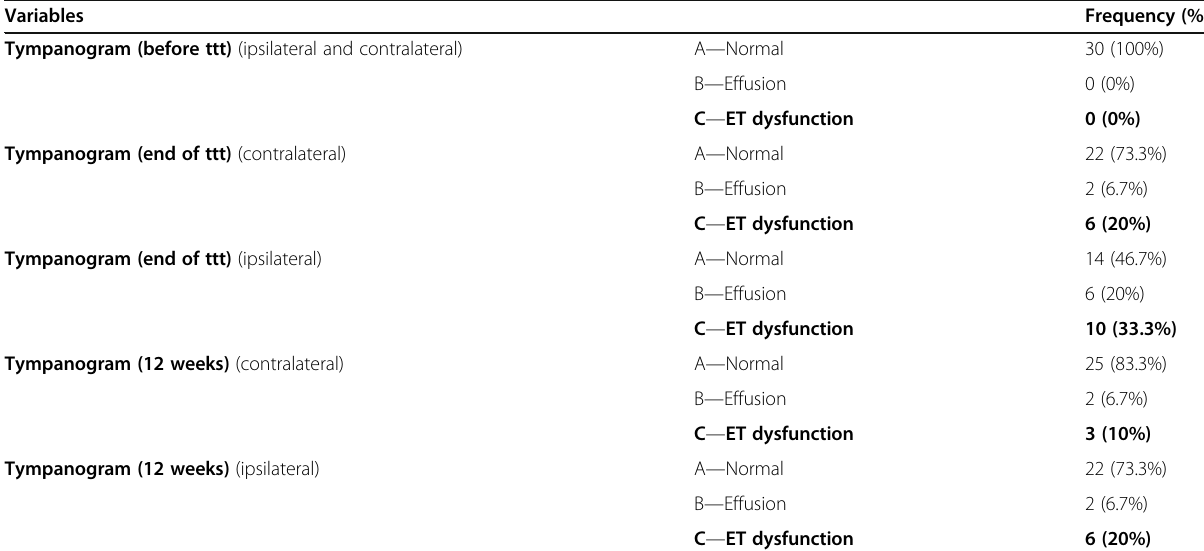
Table 3 Tympanogram (before, at end of treatment, and after 12 weeks) among 30 patients